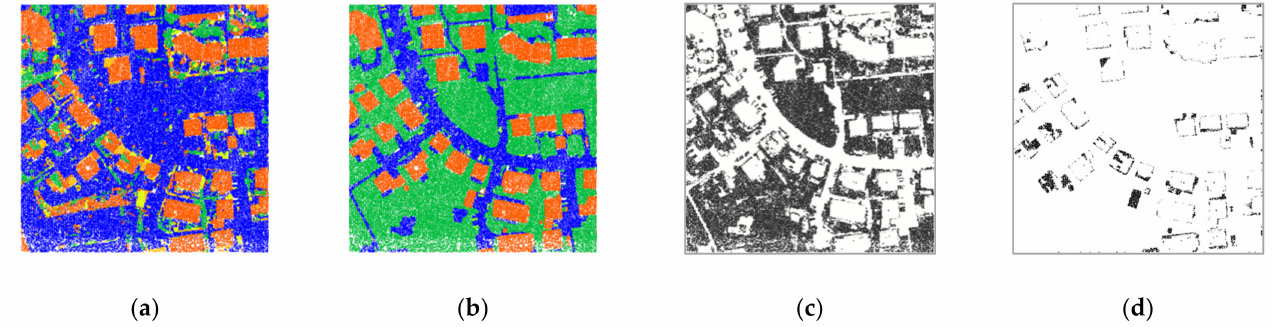
Figure 27. Results of semantic segmentation of new data 2 for Case 3: ( a ) prediction; ( b ) ground truth (i.e., label data); ( c ) difference between prediction and ground truth for all classes; ( d ) difference between prediction and ground truth for building class